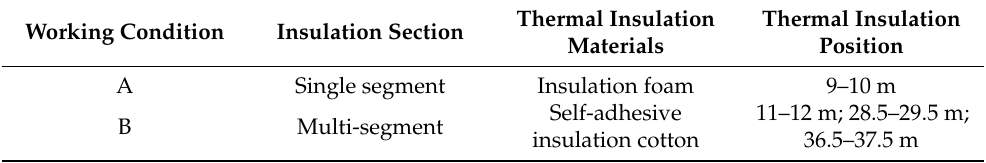
Table 1. Test conditions for abnormal detection of temperature rise and fall.